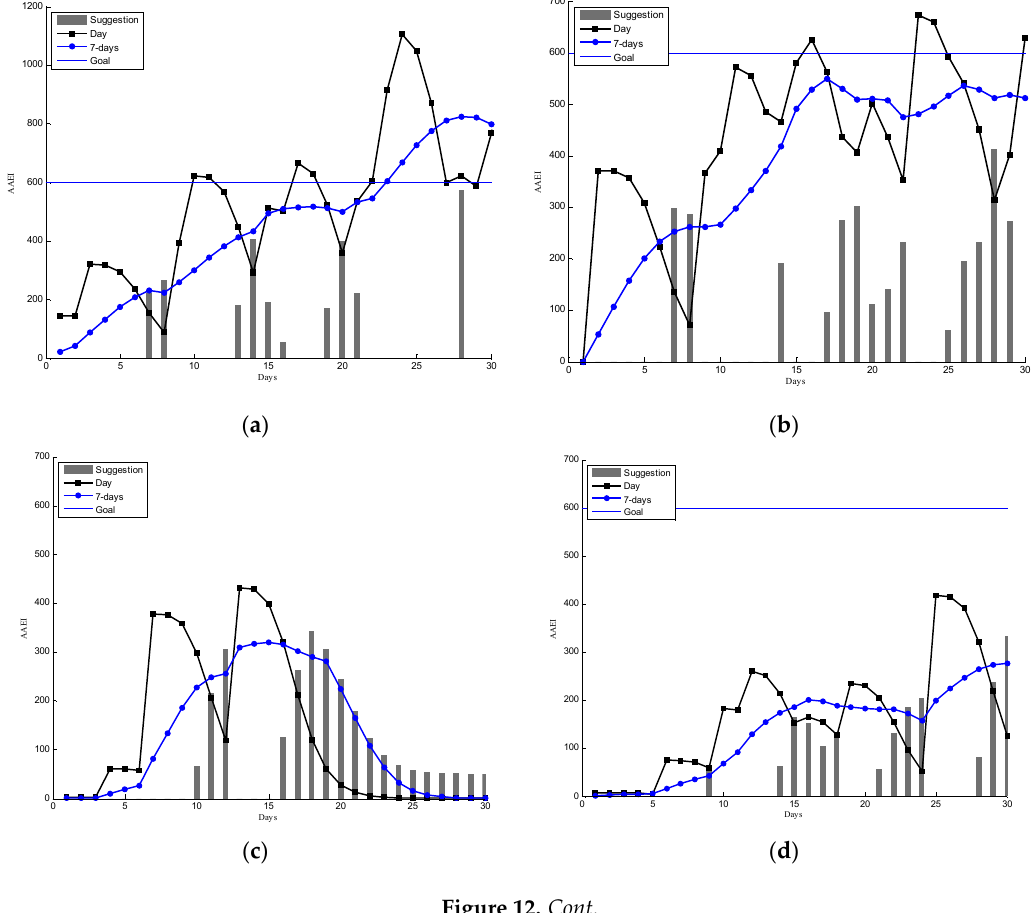
Figure 12 . Cont. Figure 12.